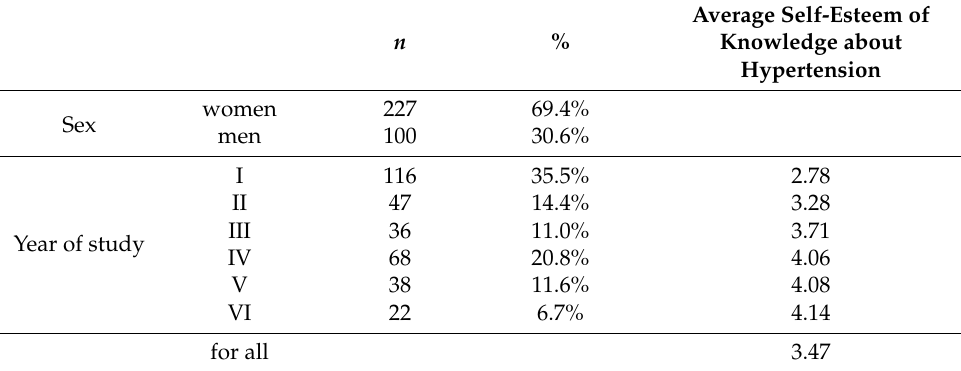
Table 1. Study group characteristics and self-reported knowledge of hypertension ( n = 327).